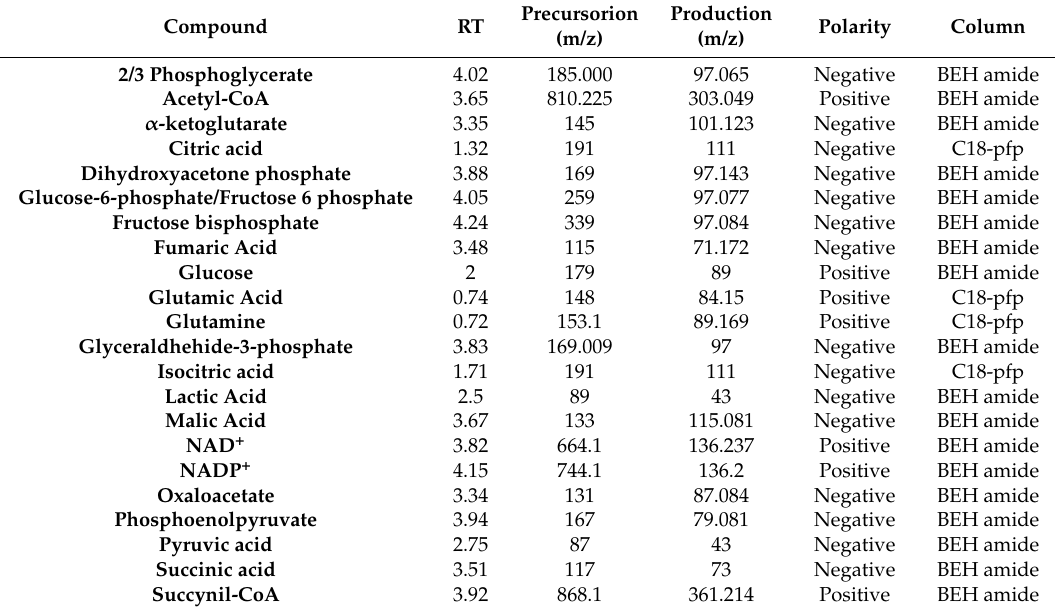
Table 2. Mass spectral data of detected compounds using